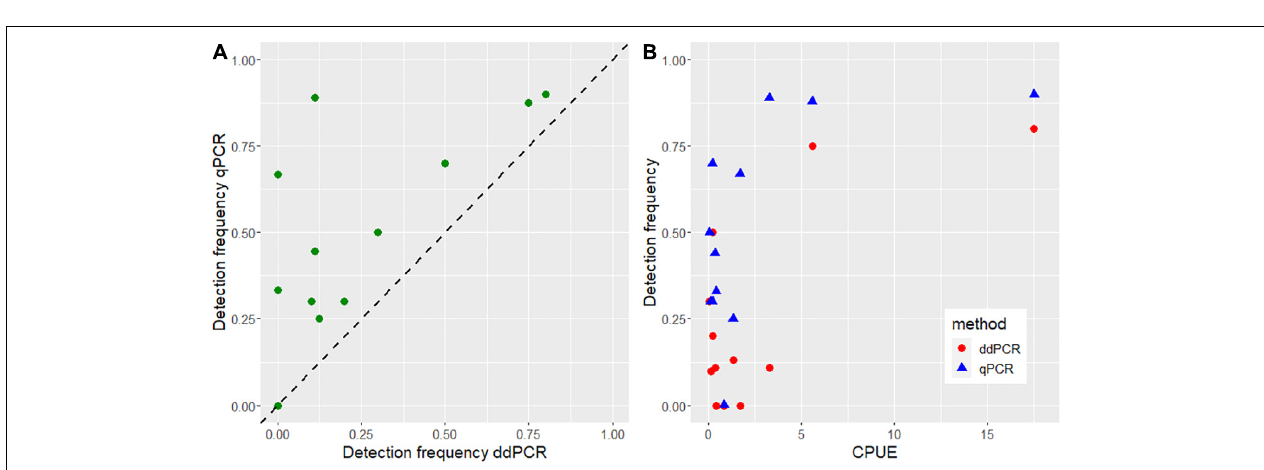
FIGURE 5 | (A) A comparison of the observed detection frequency (proportion of positive eDNA samples in a lake) between qPCR and ddPCR. The dotted line shows the 1:1 ratio. (B) A comparison of the observed detection frequency between CPUE against ddPCR and qPCR.